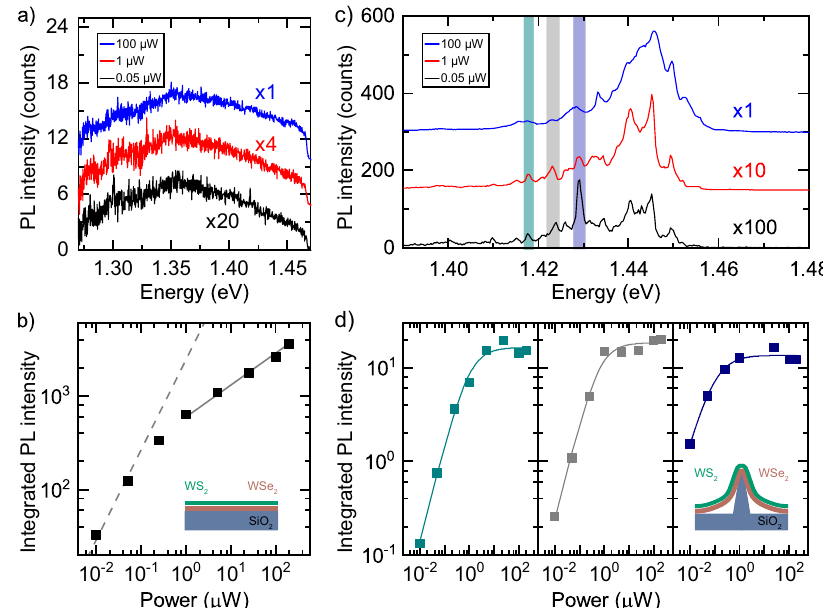
Fig. 2 Excitation-power dependence of interlayer exciton emission. a Photoluminescence (PL) spectra at 4 K from the fl at WS 2 /WSe 2 heterostructure under 1.50 eV excitation at 0.05 μ W (black curve), 1 μ W (red curve) and 100 μ W (blue curve). b Spectrally integrated intensity of interlayer exciton PL as a function of excitation power, P . The dashed grey curve follows a linear dependence in P , while the solid grey curve follows P 0.3 . Sub-linear PL intensity is also seen in device B, see Supplementary Fig. S15. The error bars are smaller than the data points. c PL spectra from the WS 2 /WSe 2 heterostructure on a nanopillar at 0.05 μ W (black curve), 1 μ W (red curve) and 100 μ W (blue curve). d Spectrally integrated PL intensity of the three emission peaks shaded with green, grey and blue bands in c as a function of P . Data ( fi lled squares) are colour-coded to the spectral bands of c . Solid curves are fi ts to data using the saturation function A × P n /( P sat + P n ), from where we determine n = 0.94 ± 0.12, 1.06 ± 0.08, 1.04 ± 0.06 and P sat = 0.1, 0.6, 0.9 μ W for the green, grey and blue data, respectively. The error bars are smaller than the data points. For the saturation curves of sharp emission peaks on device B see Supplementary Fig. S16.